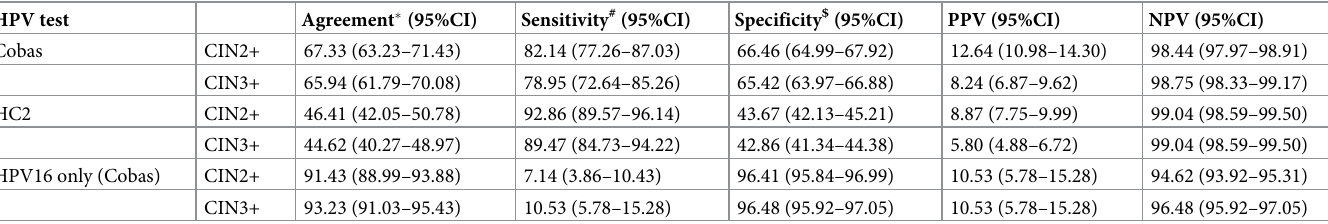
Table 5. Clinical performance of Cobas and HC2 tests for detection of CIN2+ and CIN3+ lesions. HPV